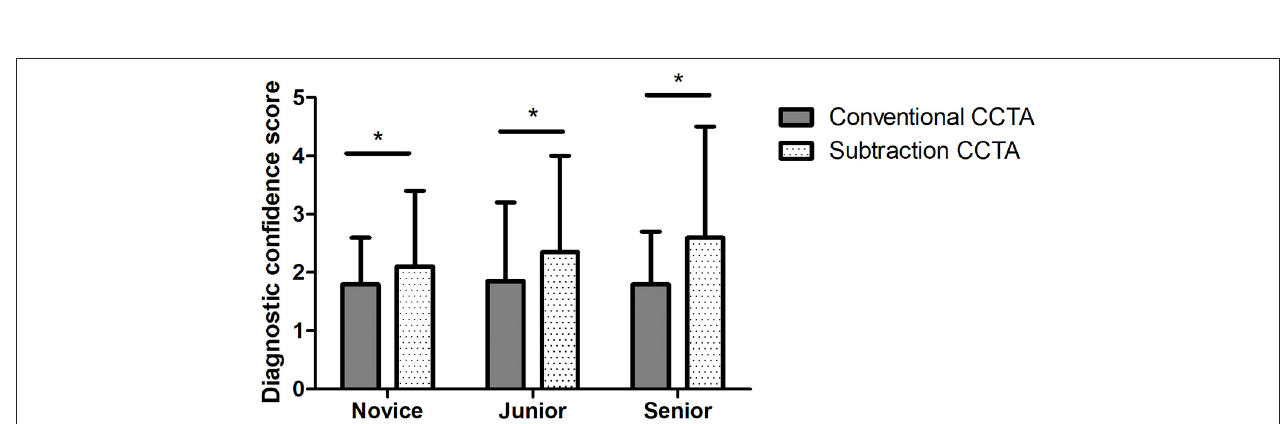
FIGURE 2 | Flowchart of patient enrollment. CCTA, coronary computed tomography angiography; ICA, invasive coronary angiography; AF, atrial fibrillation; N represents the number of patients; n represents the number of segments.